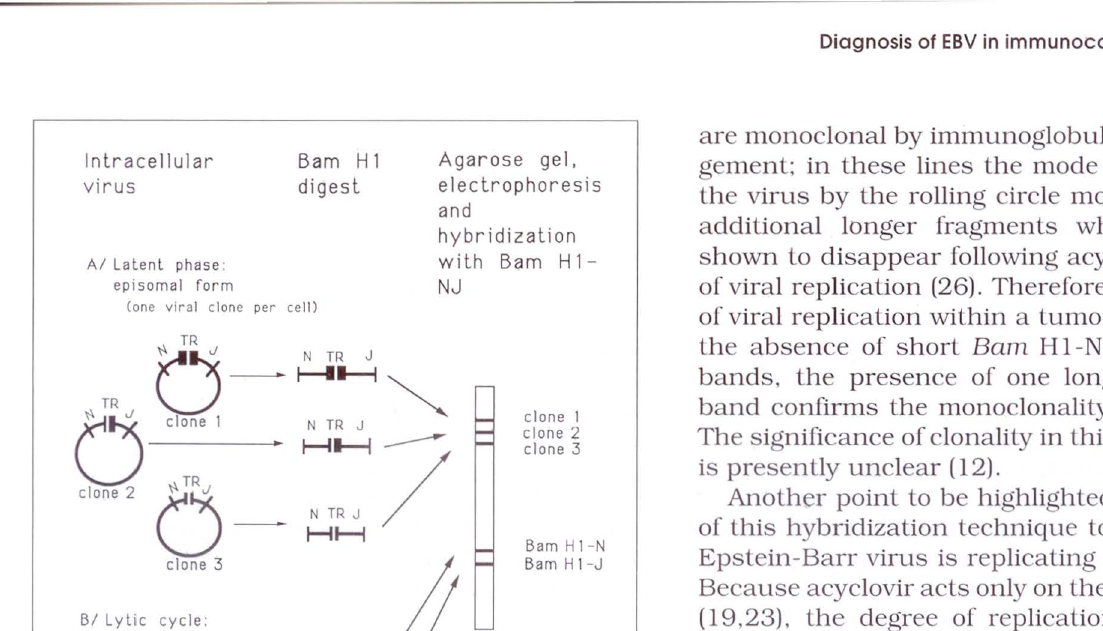
Figure 4) Schematic representation of hybridization resulis with Bam H 1-NJ probe La determine tumour clonality and the form of Epstein-Barr virus DNA (episomal or linear) contained in cetl lines or lymphoma tissue. TR Terminal repeat segment